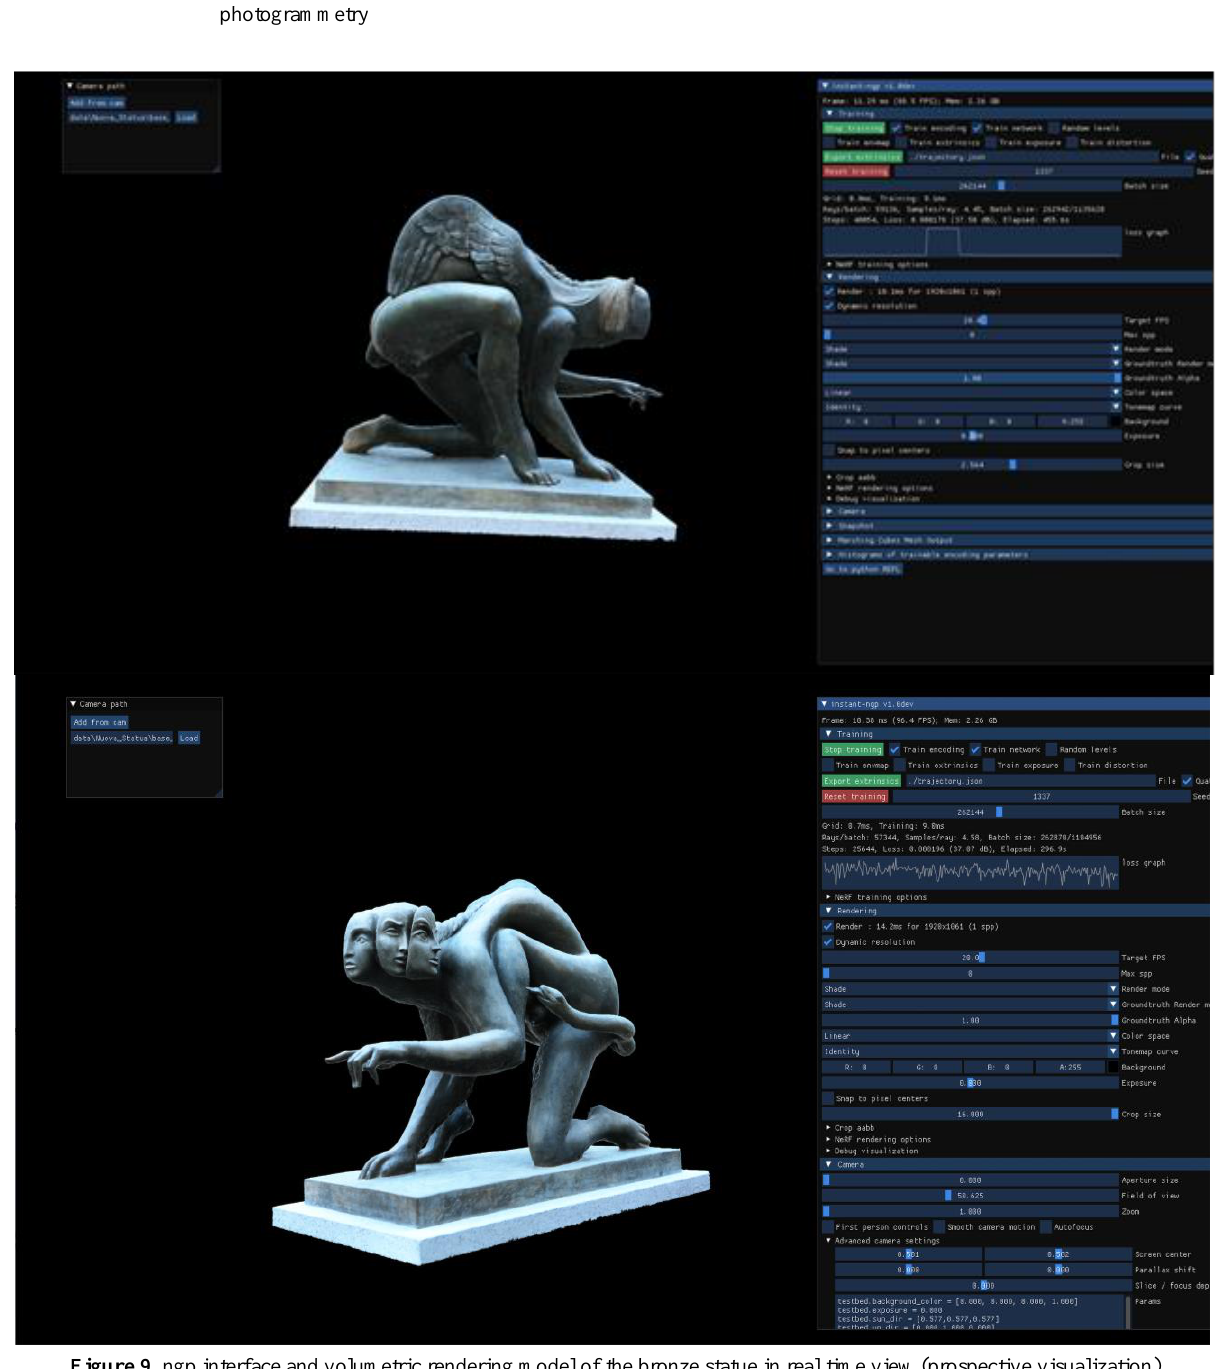
Figure 9. ngp interface and volumetric rendering model of the bronze statue in real time view (prospective